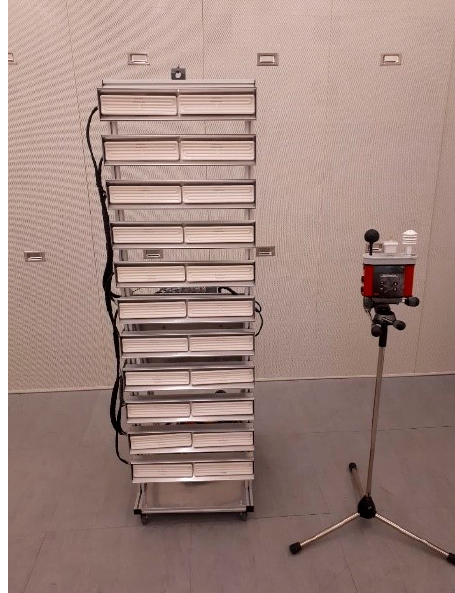
Figure 2. Radiation panel.